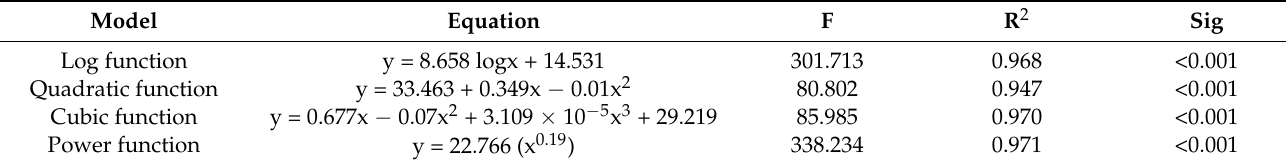
Table 1. Parameters and R 2 value of reaction kinetic model of zearalenone